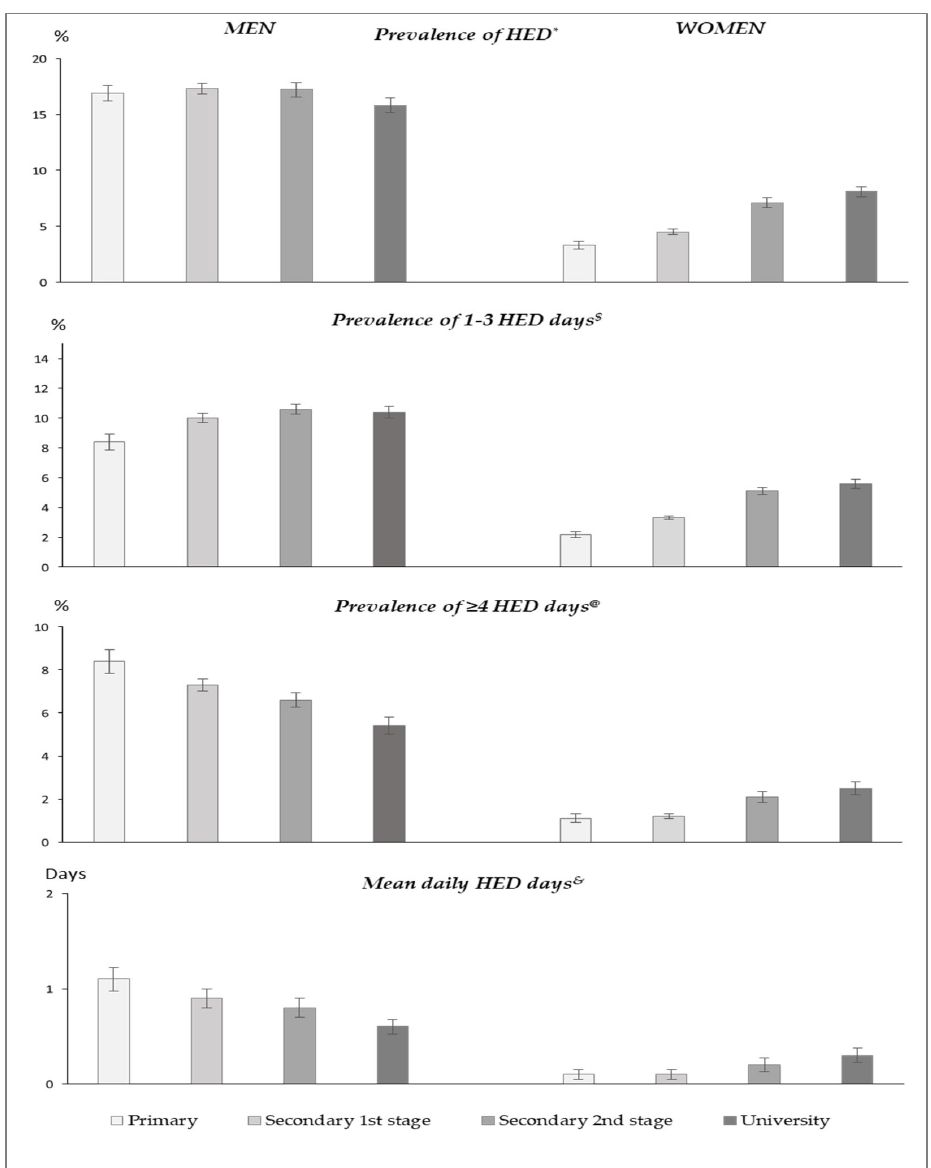
Figure 2. Age ‐ standardized measures of frequency of heavy average drinking among population aged 25–64 by sex and education level, Spain 1997–2017. Legend : Values were directly standardized using the 2013 European Standard Population weights. * Linear trends across education levels were significant both among men ( β = − 0.02, p = 0.021) and women ( β = 0.32, p < 0.001). $ Linear trends across education levels were significant both among men ( β = 0.06, p < 0.001) and women ( β = 0.32, p < 0.001). @ Linear trends across education levels were significant both among men ( β = − 0.14, p < 0.001) and women ( β = 0.30, p < 0.001). & Linear trends across education levels were significant both among men ( β = − 0.19, p < 0.001) and women ( β = 0.29, p < 0.001).